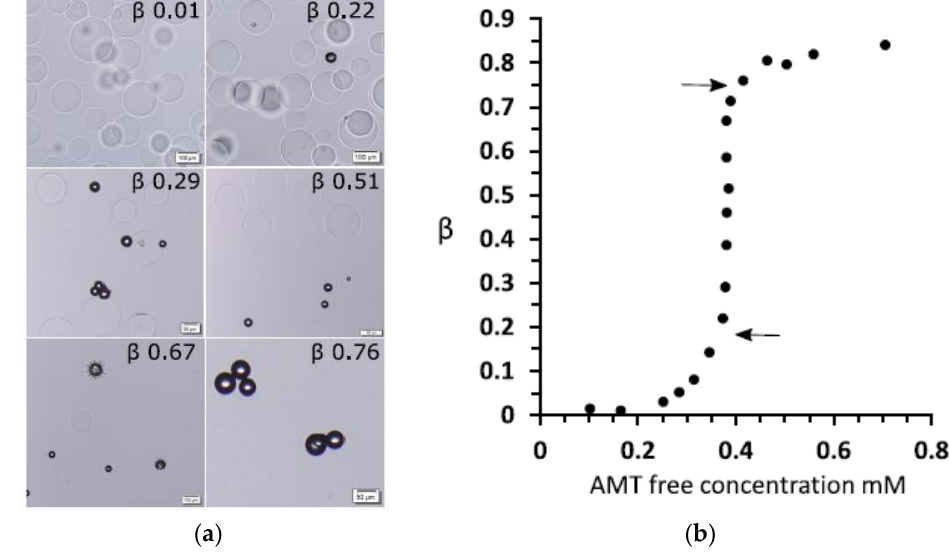
Figure 3. ( a ) Microscopy images of PA-microgels suspended in solutions of the cationic drug amitriptyline hydrochloride and 10 mM NaCl; ( b ) binding isotherm for the same system showing the drug / polyion charge ratio in the microgels ( β ) plotted vs. the free concentration of drug in the solution. Swollen homogeneous microgels coexisted with homogeneous collapsed microgels in the binding range between the arrows. Data from ref. [69].